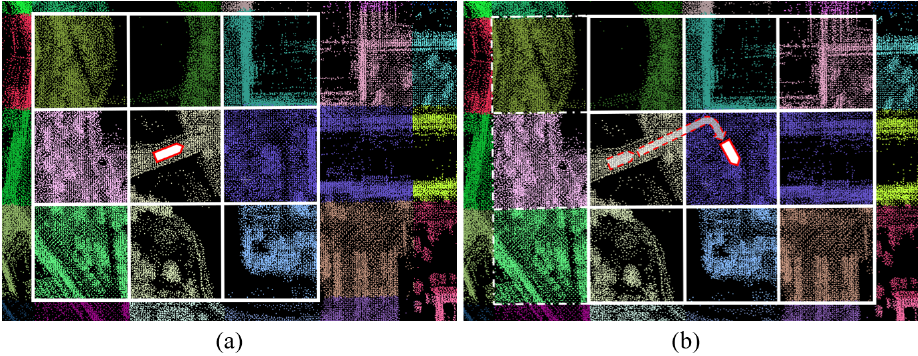
Figure 7. Point cloud map segmentation: ( a ) Submap before moving. ( b ) Submap after moving. After dividing the point cloud map, project the appropriate submaps to grid